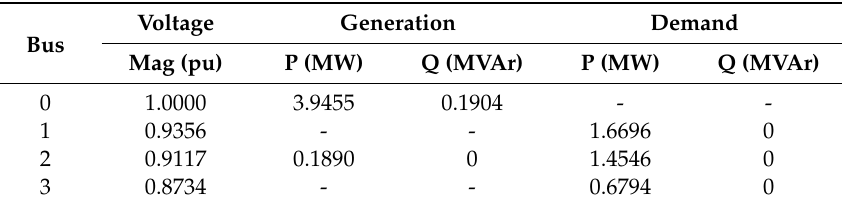
Figure 7. Operation results of the distributed energy trading algorithm. ( a ) Trajectories of the Lagrange multipliers; ( b ) Trajectories of real power on buses; ( c ) Trajectories of reactive power on lines; ( d ) Trajectories of social utility and power loss. Table 4. Optimized bus data.